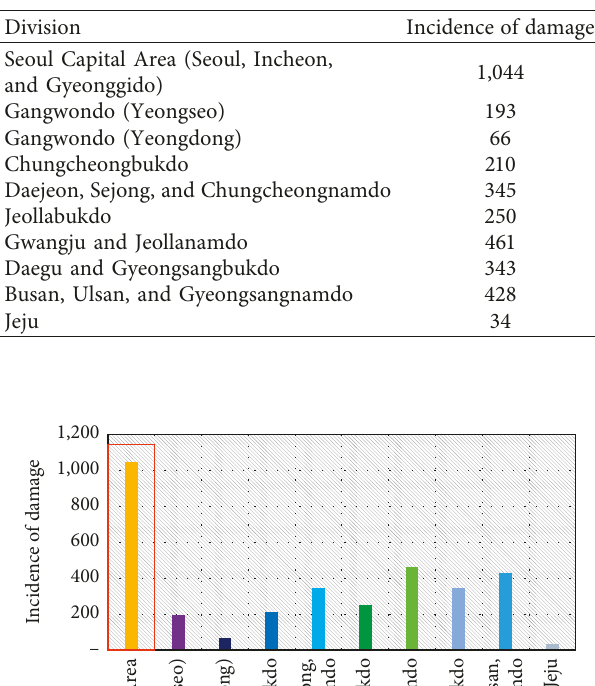
Table 1: Incidence of heavy rain damage.